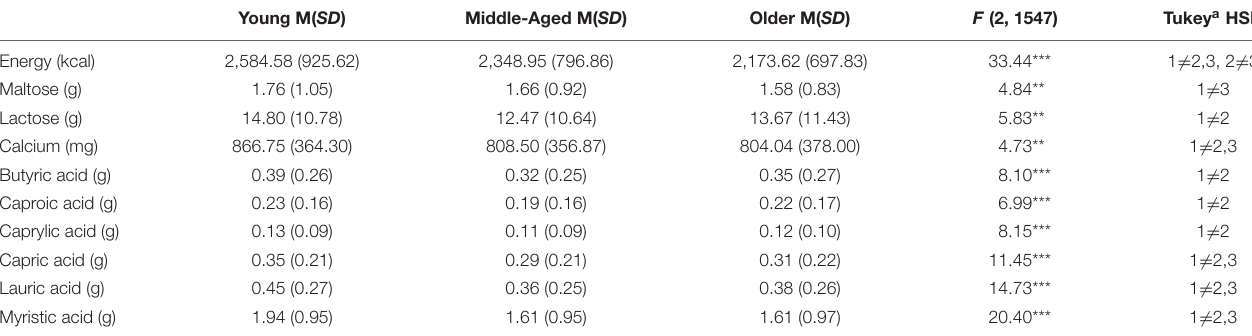
FIGURE 2 | The interaction is displayed for nutrients for which recollection performance was significantly moderated by age group. The relationship between each nutrient and recollection accuracy by age group is shown for nutrients at levels one standard deviation below the mean (low), at the mean (centered to zero) and one standard deviation above the mean (high). The color bands represent the 95% confidence interval. TABLE 9 | Mean consumption of nutrients significantly moderated by age and one-way ANOVA results across groups. Young M( SD ) Middle-Aged M( SD ) Older M( SD ) F (2, 1547) Tukey a